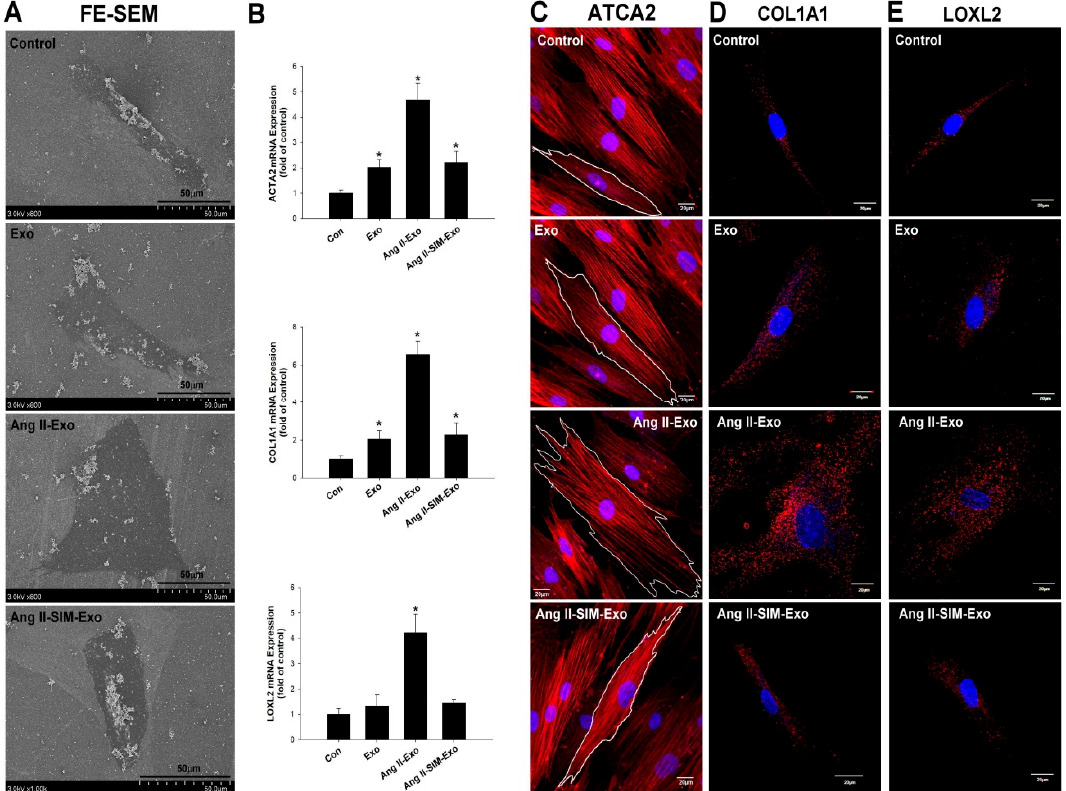
Figure 4. Simvastatin attenuates myofibroblast phenotype transformation and collagen-associated protein expression in vitro. Exosomes were isolated from HCM culture medium pretreated with Ang II or Ang II + SIM for 24 h. Exosomes were then incubated with HCF for 24 h. HCF ultrastructure images were examined using scanning electron microscopy (SEM) ( A ). mRNA expressions of myofibroblast markers ATCA2, COL1A1, and LOXL2 were examined by real-time PCR and normalized by β –actin ( B ). Data represent mean ± SD of three independent experiments (* p < 0.05). Confocal microscopy was used to confirm ATCA2, COL1A1, and LOXL2 expressions (red florescence: ATCA2, COL1A1, LOXL2; blue florescence, the nuclei) ( C–E ). A representative image from three independent experiments.